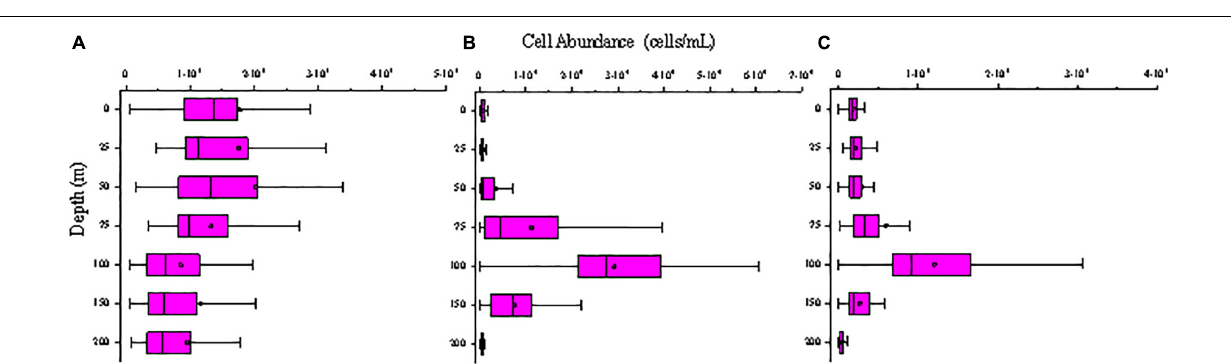
FIGURE 7 | Vertical distribution of picophytoplankton abundance (cells/mL) in the study area of (A) Synechococcus ; (B) Prochlorococcus ; (C)